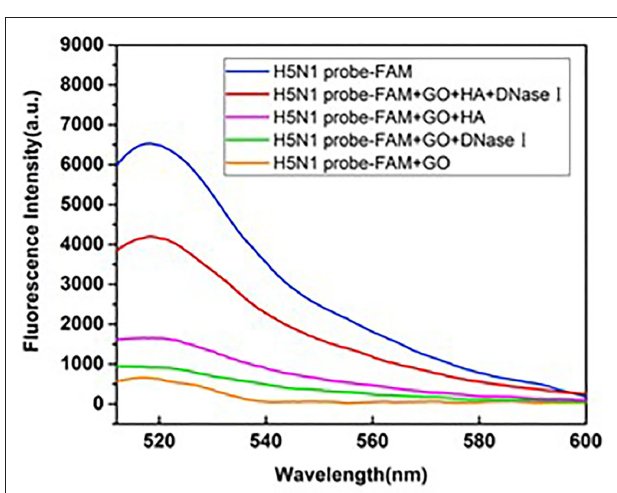
FIGURE 5 | Feasibility of GO quenching and DNase I cleavage in the reaction